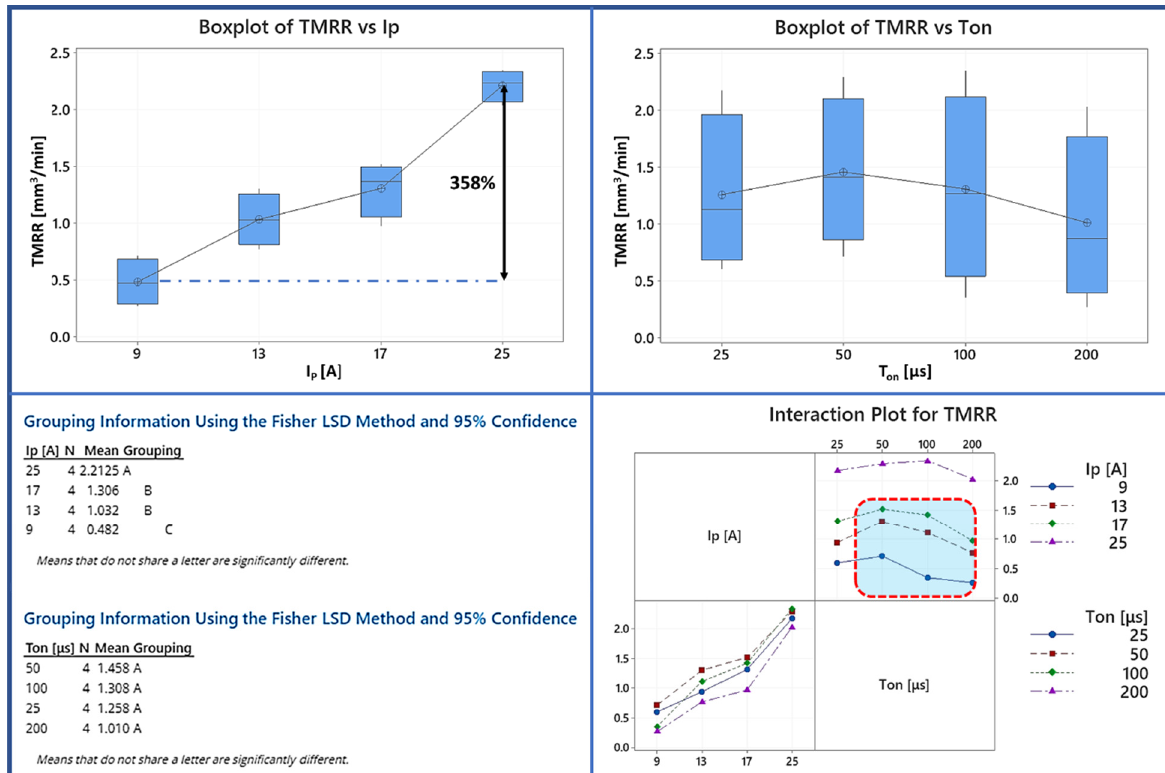
Figure 5. Box plot, interaction plot of TMRR and the results of the Fisher statistically significant test.